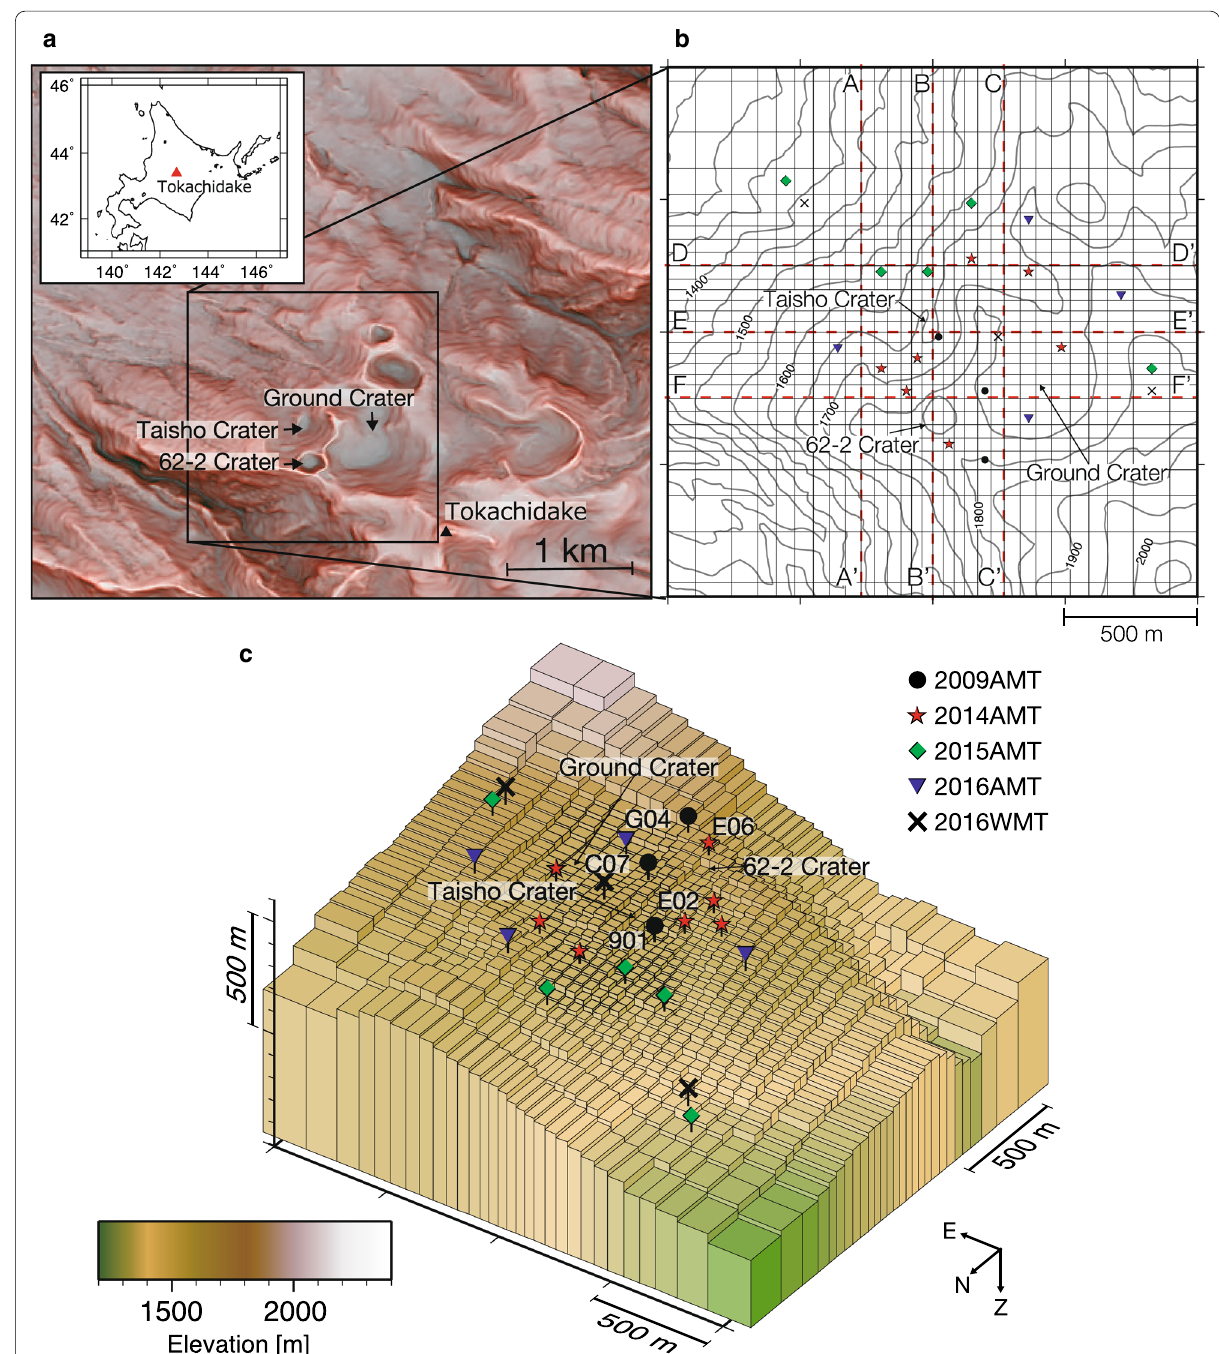
Fig. 1 Topographic map of the study area and computational mesh of the central part used in the three-dimensional (3-D) resistivity inversion. a Maps showing the location of Mt. Tokachidake (inset) and local topography (red relief image map). b Topography of the area around the core region of the computational domain and spatial distribution of the magnetotelluric measurement sites used in this study. The contour interval is 50 m. The black circles, red stars, green diamonds, blue inverted triangles, and black crosses indicate the 2009, 2014, 2015, and 2016 audio-frequency magnetotelluric (AMT) observations, as well as the 2016 WMT observations, respectively. c Surface mesh around the core